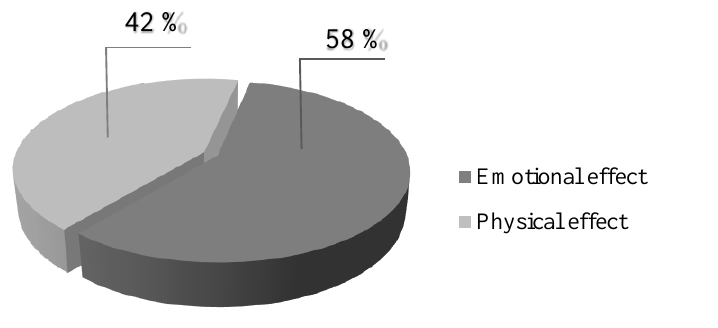
Fig. 1. Ratio of references to the physical and emotional effects of lighting in the reviewed studies.